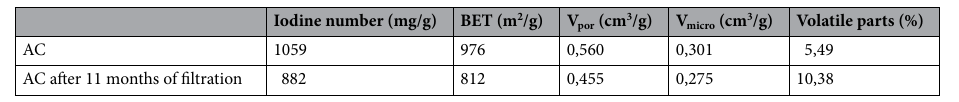
Table 7. Textural parameters for the AC activated carbons before and after 11 months exploitation.